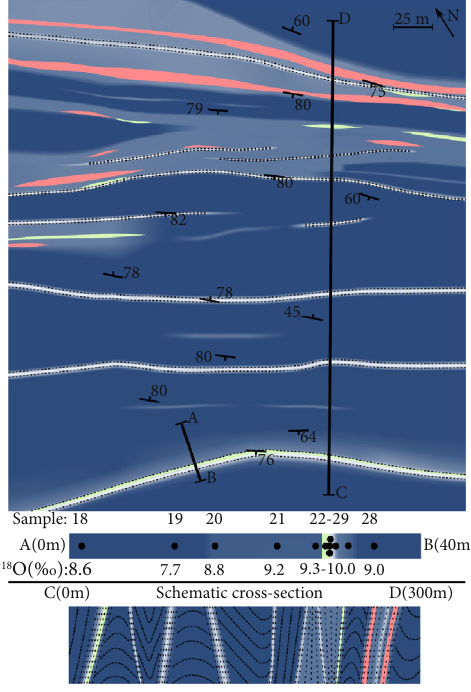
Figure 3: Map of area D, including the sampled transect (A-B) with samplelocationsand δ 18 Ovaluesandschematiccross-section(C-D). Colours are the same as in Figure 2. Dashed lines on the map marks the boundary between protomylonite and mylonite. The ultramylonites are too thin to mark with dashed lines. Rock descriptions and GPS locations can be found in Table